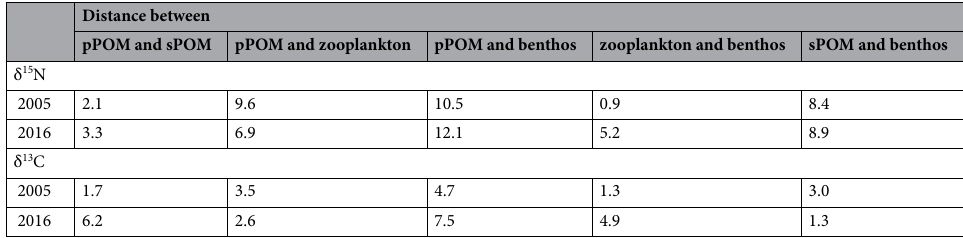
Table 2. Isotopic distances between means of δ 15 N and δ 13 C (‰) of endmembers (pPOM, sPOM) and consumers (zooplankton, benthos) from the Chukchi Borderland in 2005 and 2016. See Table 3 for pPOM and sPOM abbreviations.